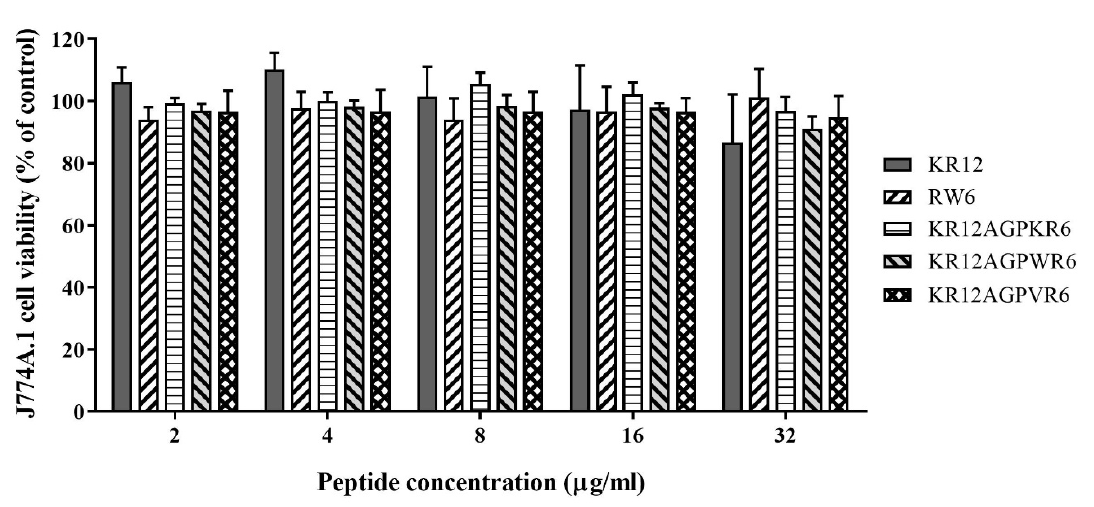
Figure 4. Cytotoxicity to murine macrophage J744A.1 cells of KR12, RW6, KR12AGPKR6, KR12AGPWR6 and KR12AGPVR6. Data are representative of at least three independent experiments and results are presented as means ± standard deviations (SD).